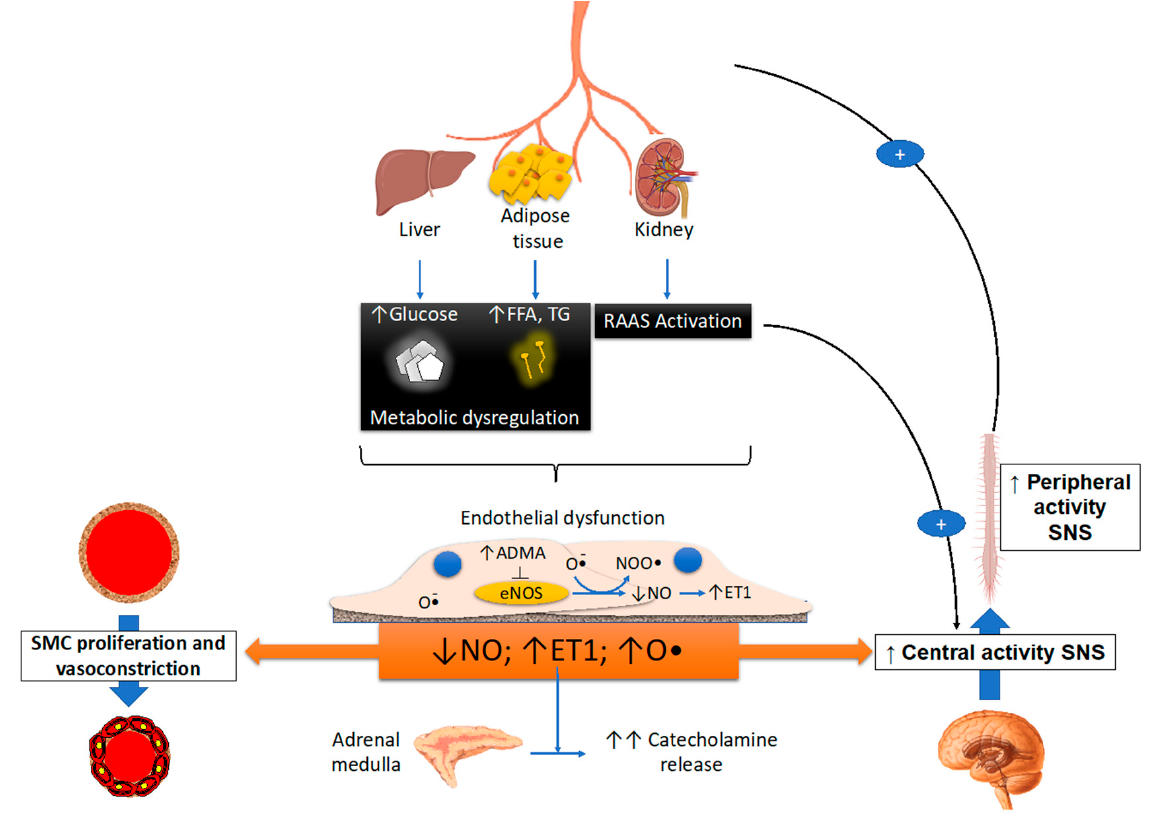
Figure 1. Schematic drawing illustrating the metabolic, endothelial, nitric oxide and vascular smooth cell proliferation of central and peripheral stimulation. ET: endothelin, FFA: free fatty acid, TG: triglycerides, NO: nitric oxide, O: oxide, ADMa: asymmetric dimethylarginine, RAAS: renin-angiotensin system, SMC: smooth cell proliferation, SNS: sympathetic nervous system. The symbol + refers to a stimulating effect, while arrows refer to the possible interactions between various variables.